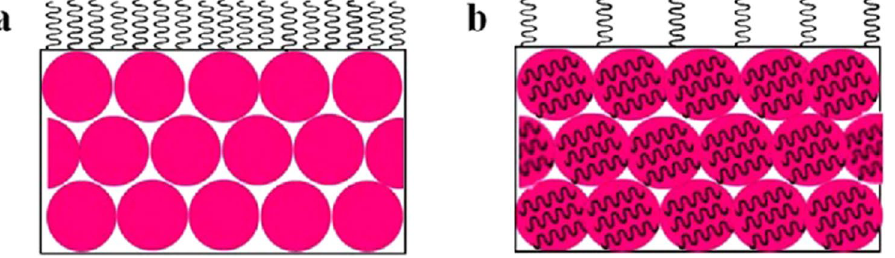
Figure 6. Schemes for the distribution of HD in the film of CEP + HD ( a ) and MP ( b ). CEP + HD represents the emulsion containing HD synthesized by CEP, MP signifies miniemulsion polymerization.